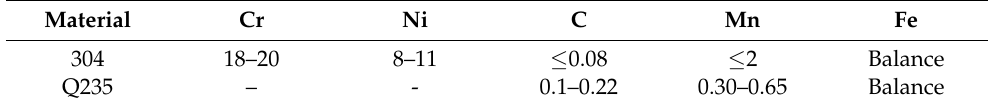
Table 1. The main chemical composition (wt.%).